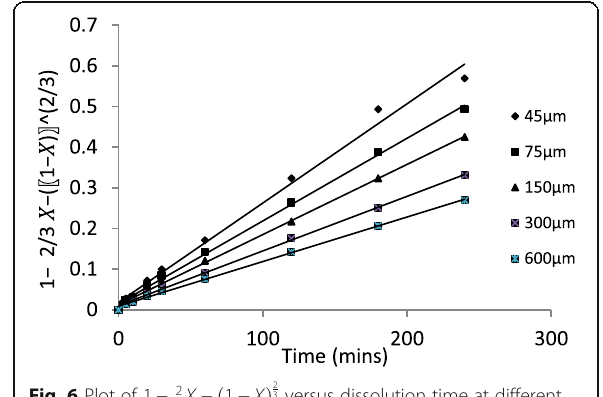
Fig. 4 Plot of 1 − (1 − X ) 1/3 versus dissolution time at different ore particle sizes